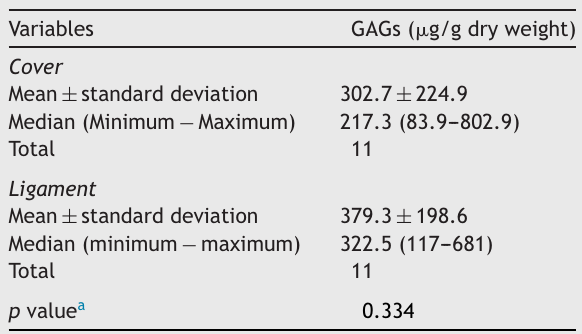
GAG concentration in the vocal fold cover and